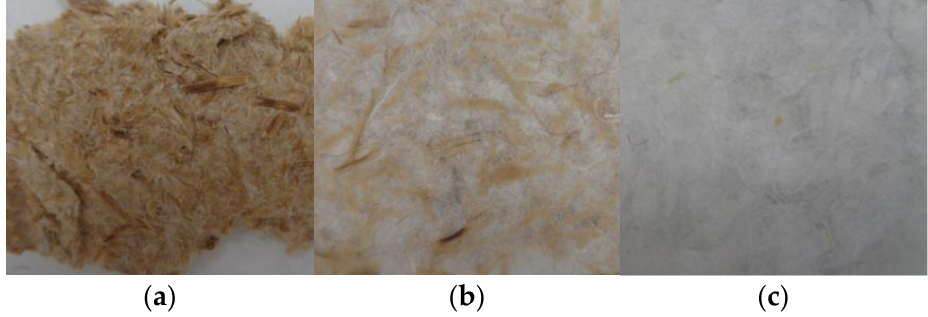
Figure 7. Cellulose fibers extracted with different conditions resulting from the steam-explosion process (Step2). ( a ) 15 min, ( b ) 25 min, ( c ) 33 min.